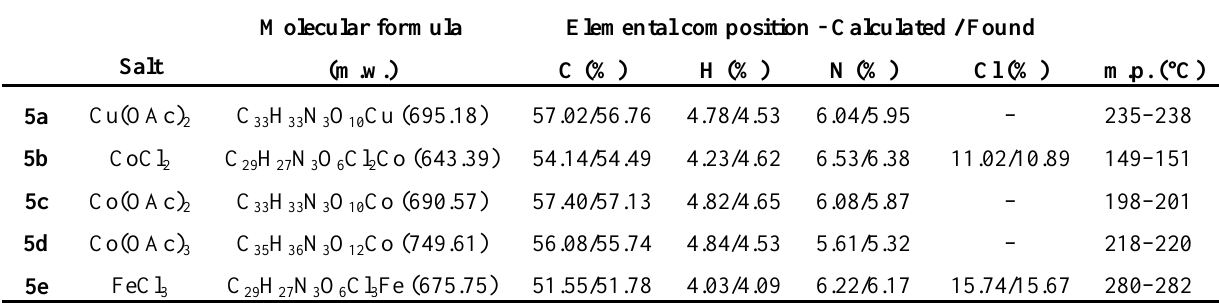
Table 5. Microanalysis data for compounds 5a-e